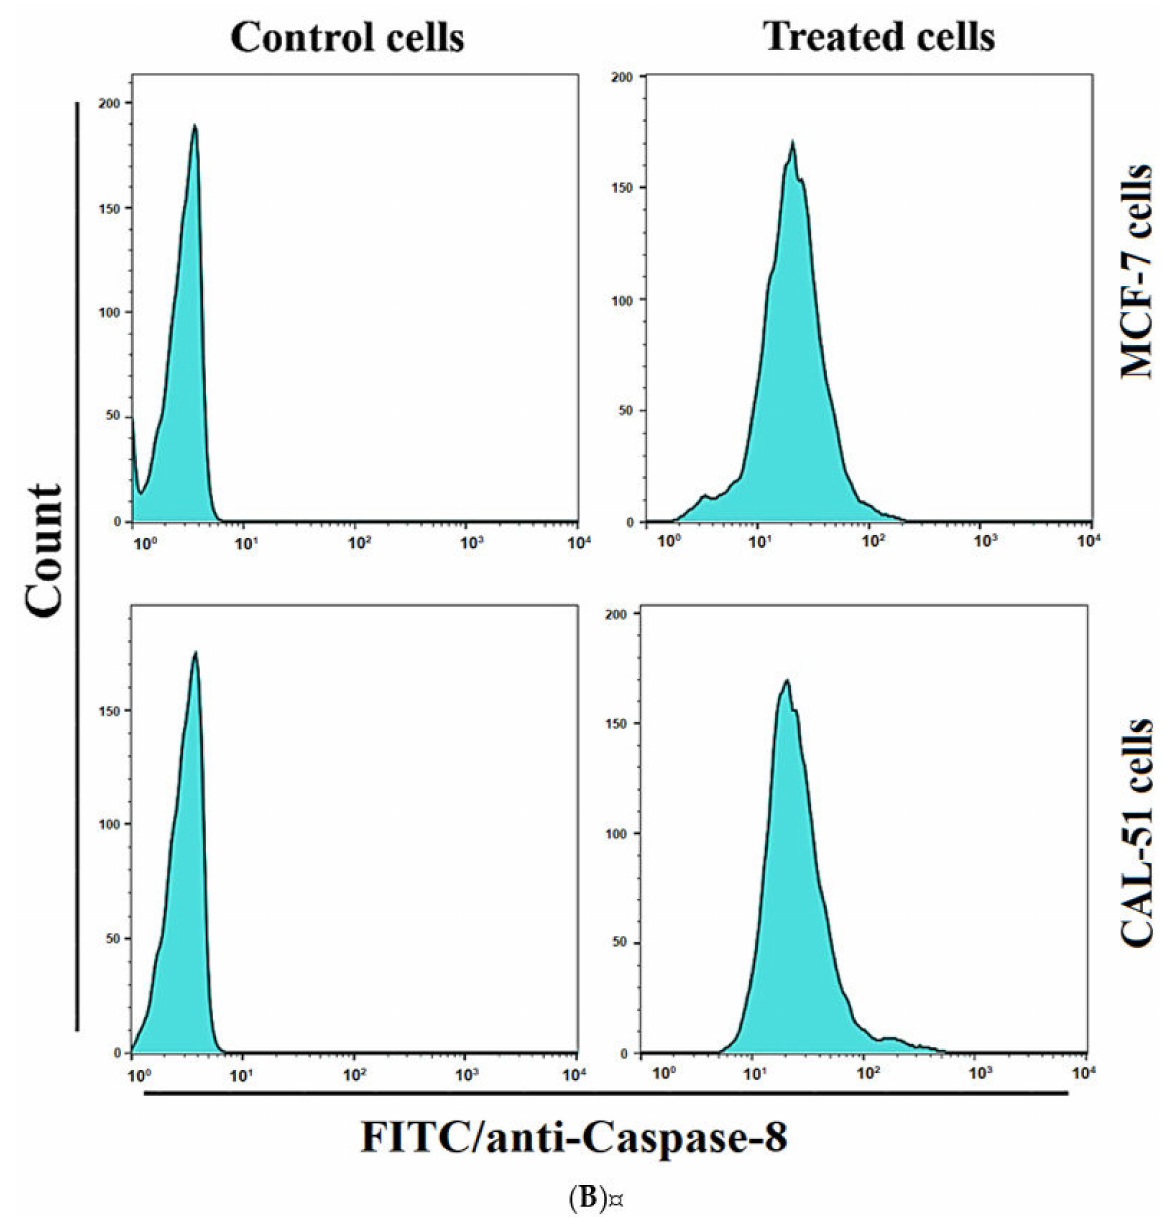
Figure 14. TAM/RES–LbL-LCNPs regulated p53 ( A ) and caspase-8 ( B ) levels in MCF-7 and CAL-51 cells. A flow cytometer assessed fluorescence histograms of p53 and